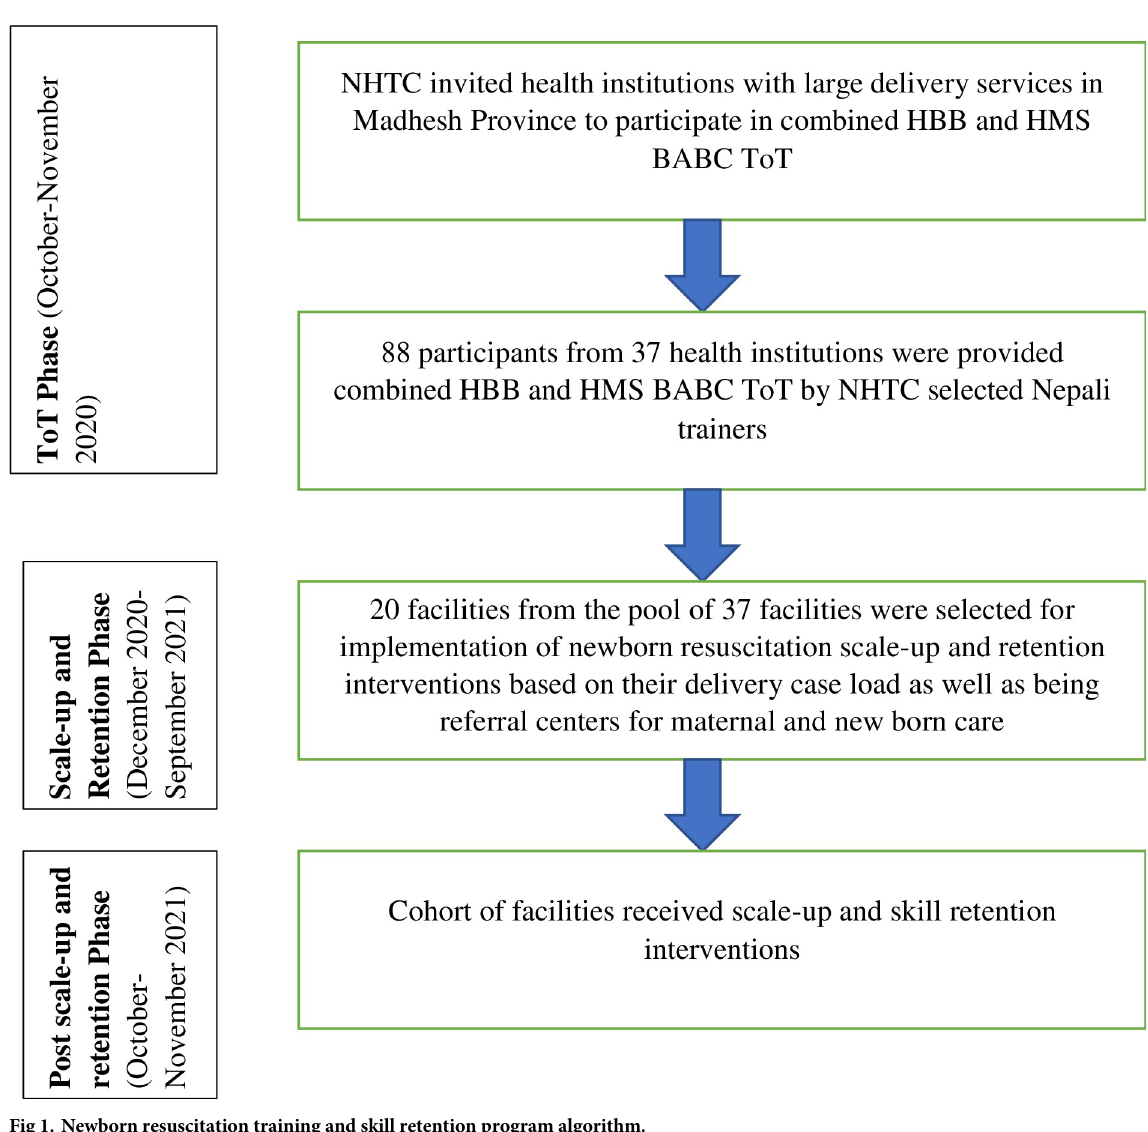
Fig 1. Newborn resuscitation training and skill retention program